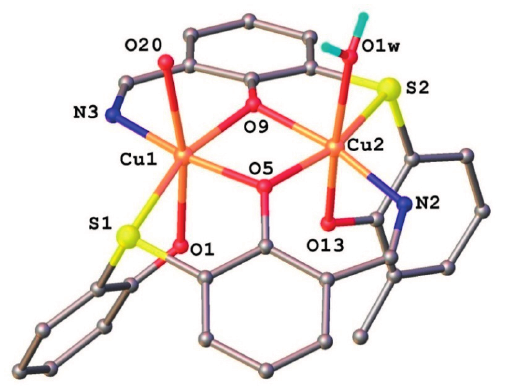
Figure 8. The coordination mode for the copper atoms of in the binuclear complex [Cu 2 (L 2 S) 2 (ClO 4 ) (H 2 O)] + .